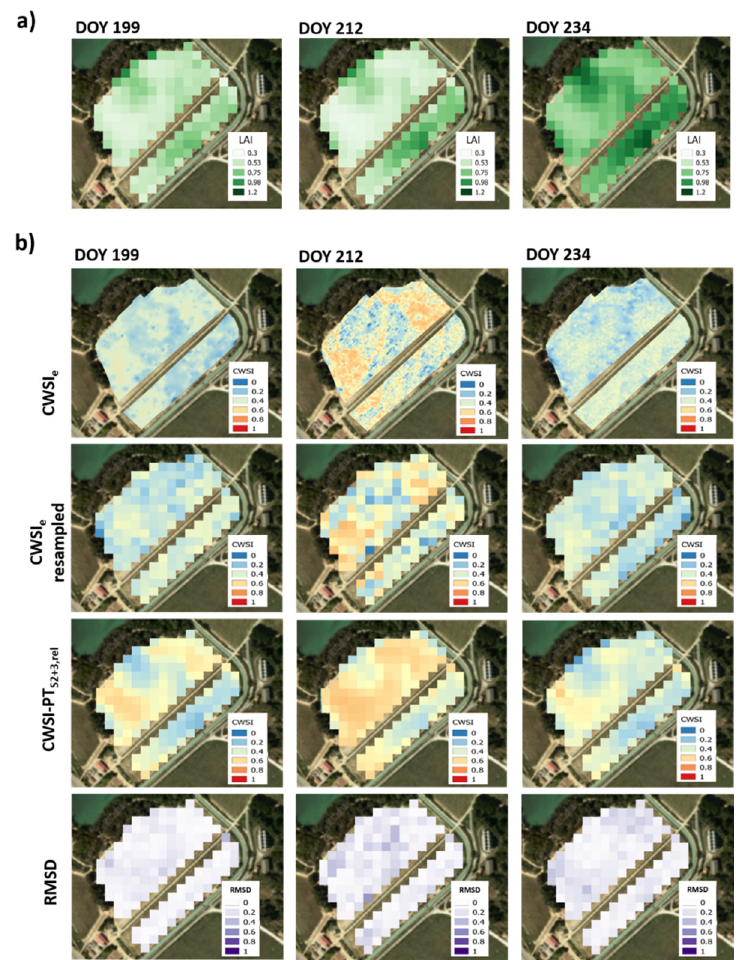
Figure 7. ( a ) Maps of LAI obtained with Sentinel-2 for DOY 199, 212 and 234, and ( b ) comparison of spatial variability in the vineyard’s crop water stress index (CWSI) for the same dates, using the empirical baseline approach with very high-resolution thermal images (CWSI e ) vs. the relative CWSI (CWSI-PT S2 + 3,rel ) obtained with sharpened S2 and S3 images and the Priestley–Taylor model.